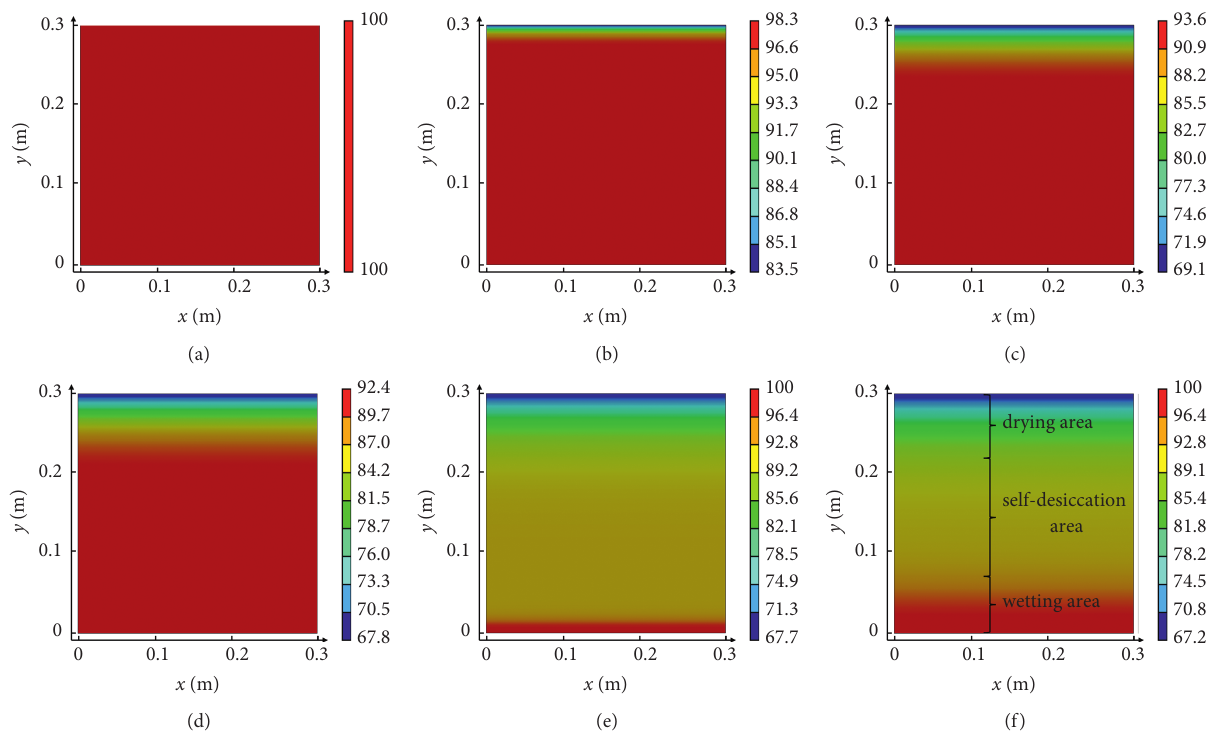
Figure 7: RH contour of concrete specimen at different times. (a) t � 0 d, (b) t � 1d, (c) t � 14d, (d) t � 28d, (e) t � 29 d, and (f) t �